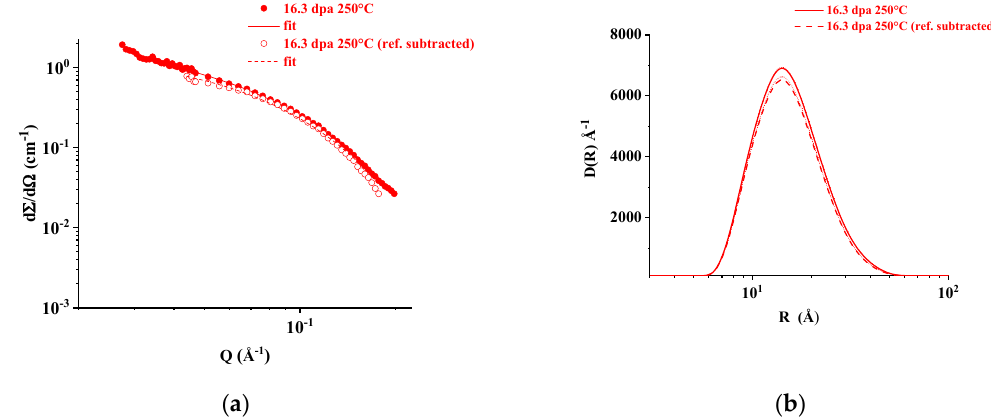
Figure 8. Eurofer97 neutron irradiated to 2.7 dpa at 300 °C: ( a ) best fits to nuclear SANS cross-section without (full circles) and with (empty circles) subtraction of reference sample’s cross-section, ( b ) best-fit micro-void distributions (Å − 1 ) obtained without (continuous line) and with (dashed line) subtraction of reference sample’s cross-section. The 80% confidence bands are indicated by the dotted line s.